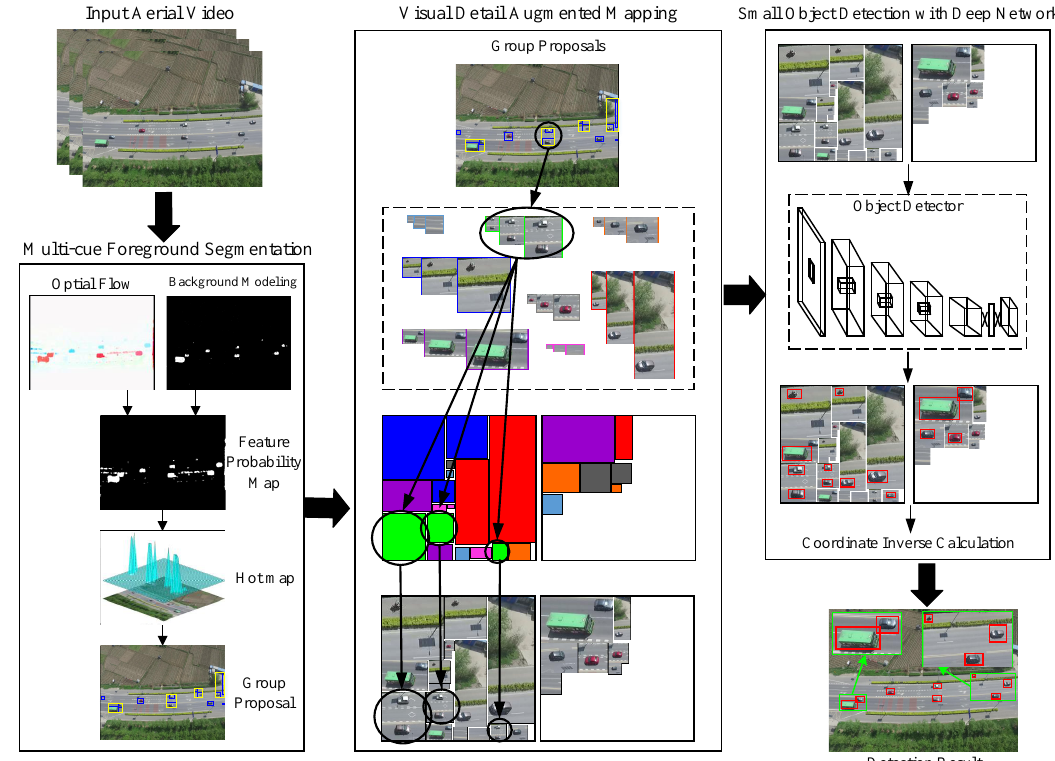
Figure 3. An illustration of the proposed method. The small target detection method contains three parts: multi-cue foreground segmentation, visual detail augmented mapping, and small object detection with the deep network. After the three modules, small targets can be detected accurately and quickly from the input aerial